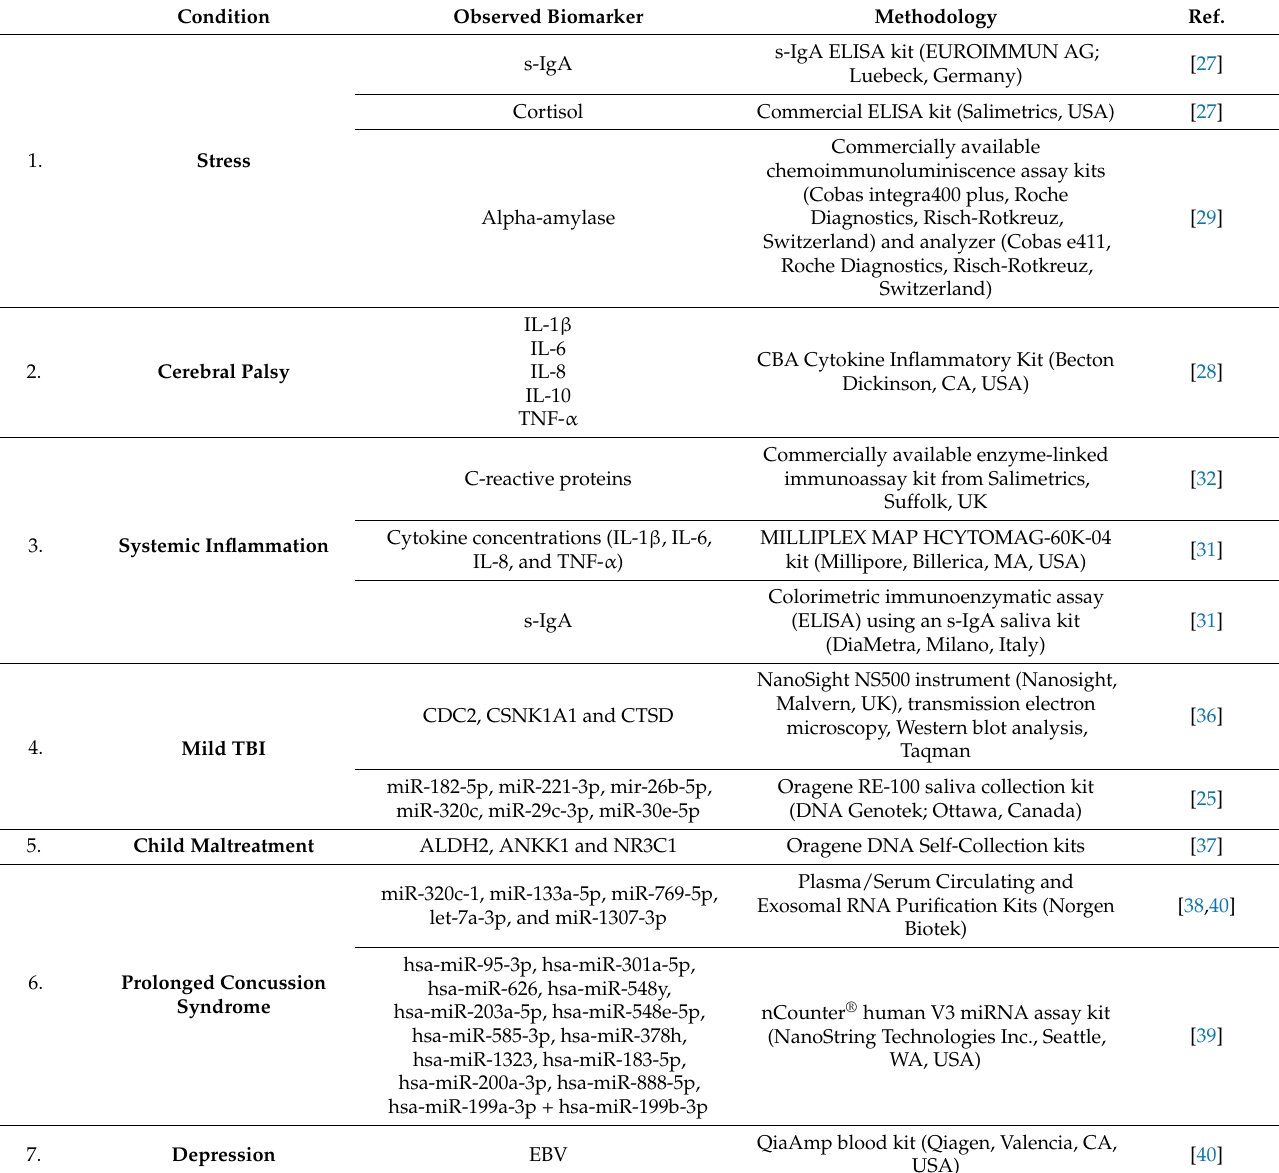
Table 3. Neuropsychiatric conditions and their respective